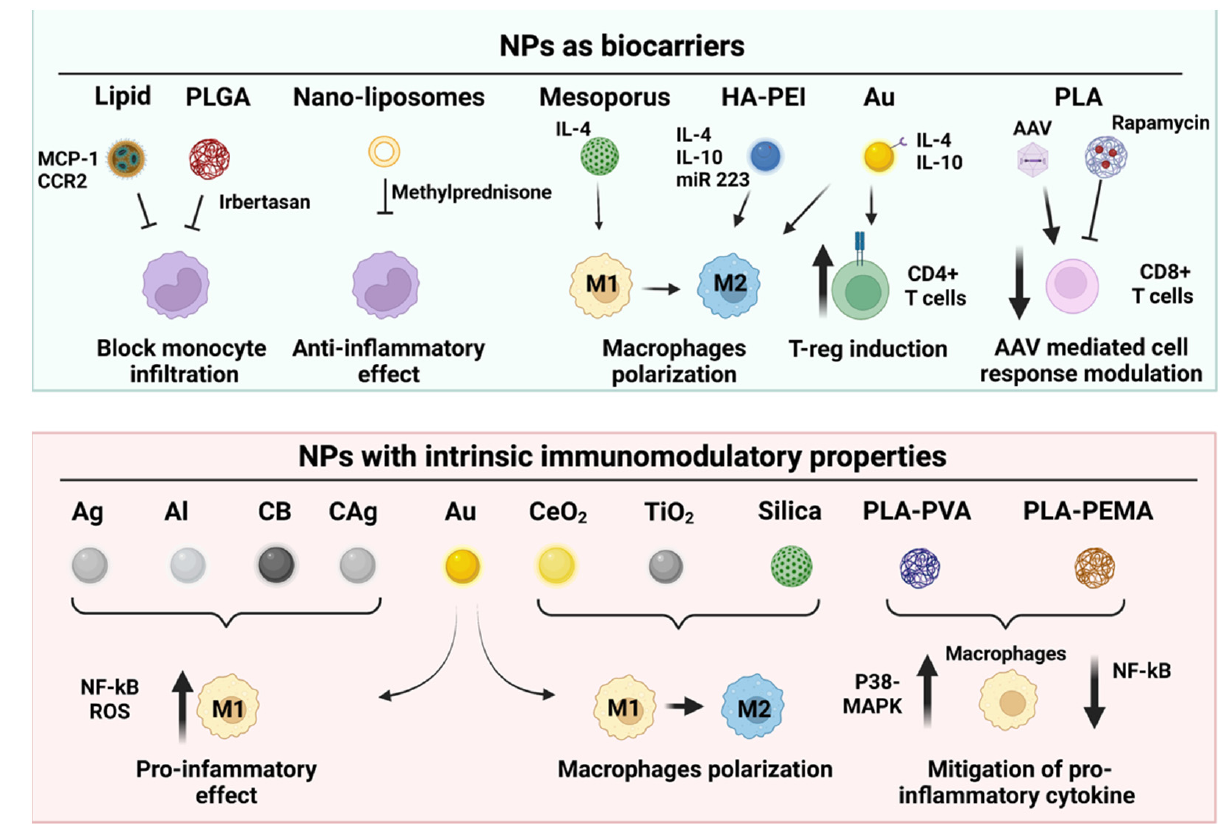
Figure 2. Nanoparticles-based strategies for immunomodulation in muscle diseases. Overview of different types of NPs used as biocarriers to deliver immunomodulatory agents and of NPs with the intrinsic ability to modulate the inflammatory response. (NP, nanoparticle; PLA, poly (lactic acid); PLGA, poly(lactic- co -glycolic acid); PVA, (poly(vinyl alcohol)); PEMA (poly(ethylene-alt-maleic acid)); HA-PEI, hyaluronic acid-poly ethyleneimine; AAV: Adeno-associated virus; Ag, Silver; Al, Aluminium; CB, Carbon black; CAg, Carbon-coated silver; Au, Gold; TiO2, Titanium oxide; CeO2, Cerium oxide. The mechanism of action on the different immune cell populations is also shown.